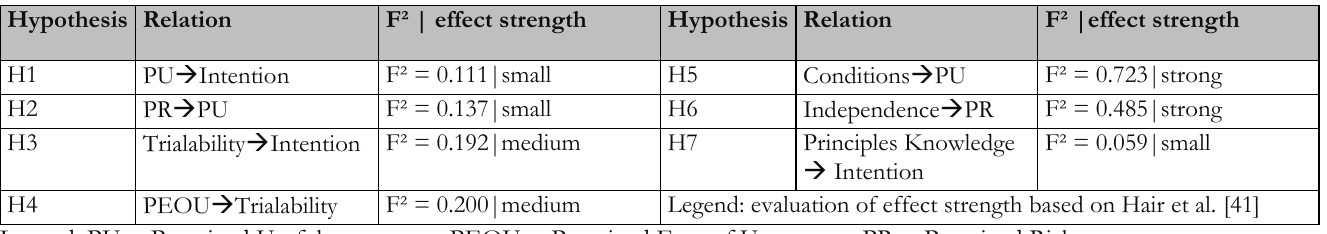
Table 9. Effect sizes of the Structural Equation